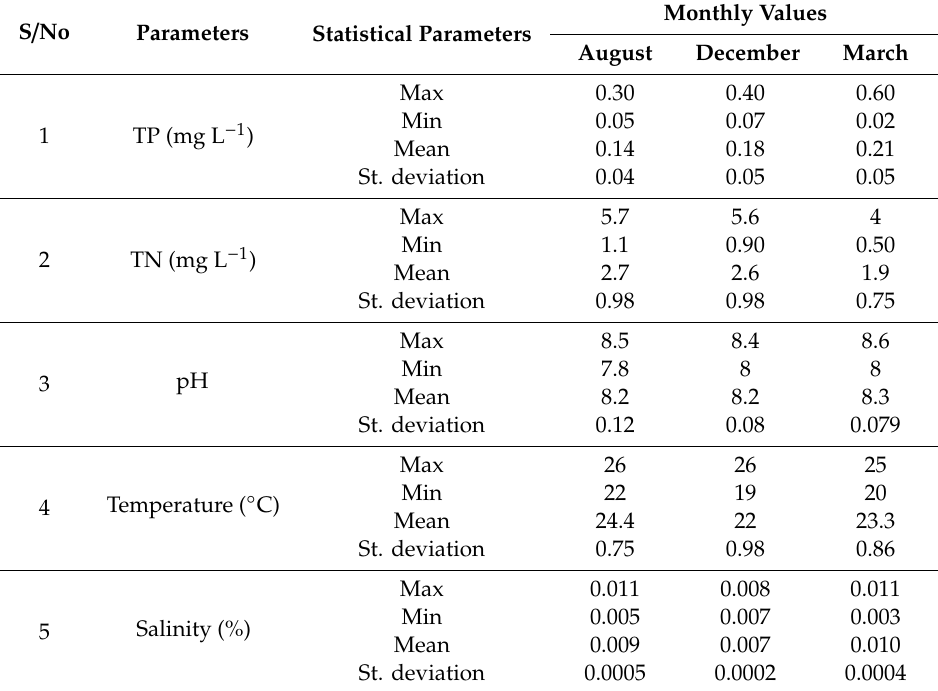
Table 1. The temporal values of selected physicochemical water quality